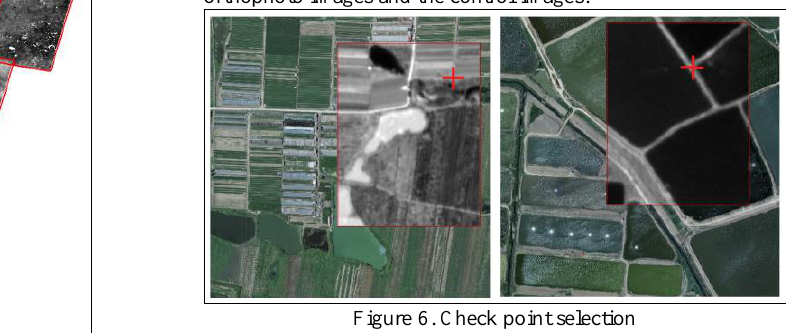
Figure 6. Check point selection